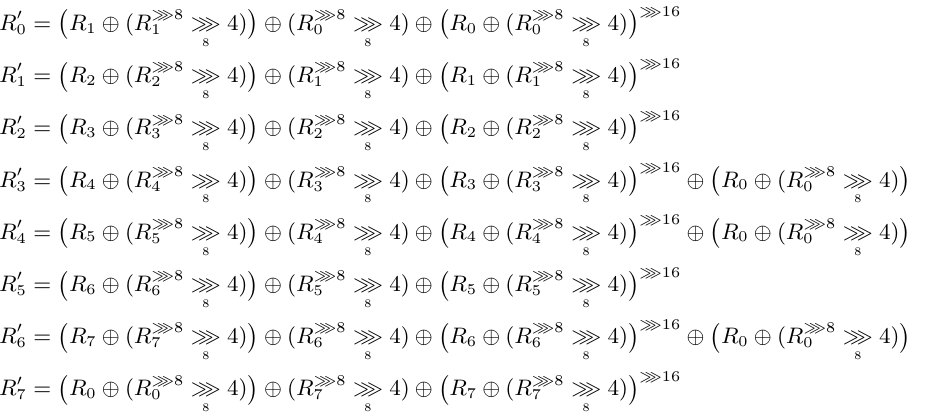
Figure 7: Equations to compute the MixColumns during the second fixsliced round where R i ≫ j refers to a byte-wise rotation of j bits to the right, for all bytes within R i . 8 Due to the ShiftRows transformation, the third round configuration will be similar to the first one except that each row will be delayed by one byte shift to the right (instead of left) in comparison to its adjacent rows. Therefore the computation of the fixsliced MixColumns in the third round is the same as in the first round, with a slight modification: byte-wise rotation values have to be reversed. For instance, the update of R